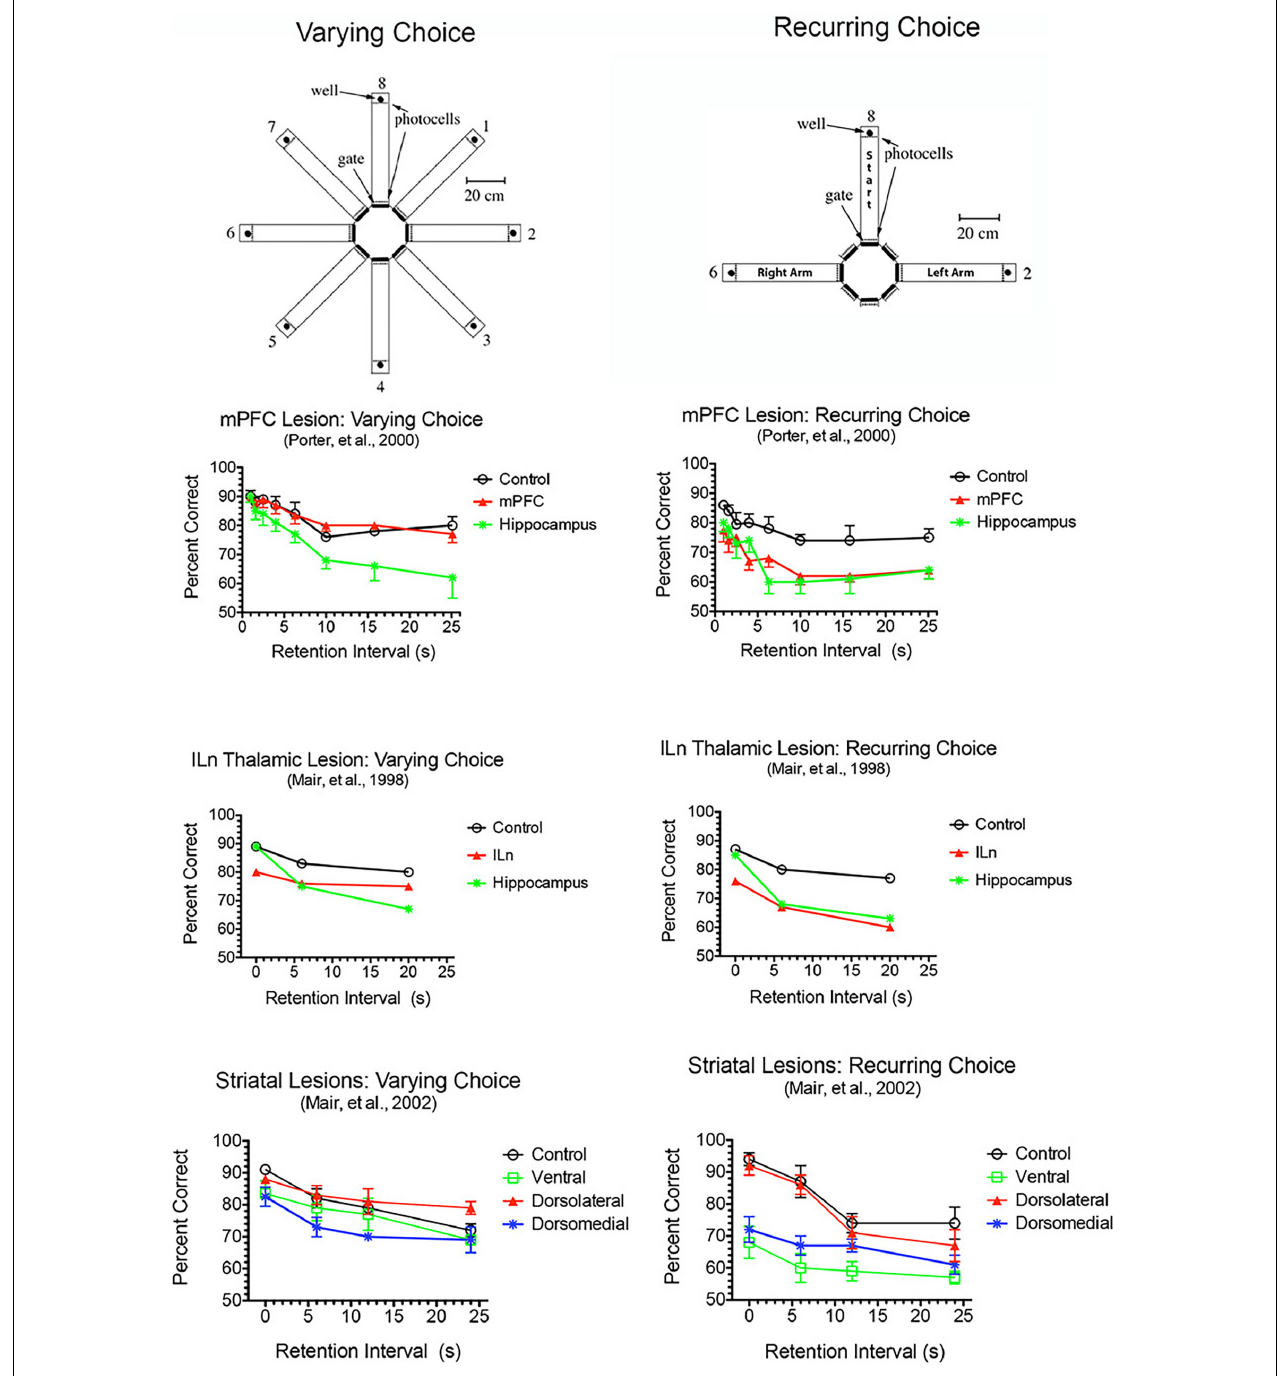
FIGURE 4 | Effects of mPFC, hippocampal, intralaminar thalamic (ILn), and striatal lesions on varying- and recurring-choice DNMTP trained in automated eight arm radial mazes. In varying choice DNMTP arms were selected at random from all available options for start, sample, delay, and choice responses in a lighted room with many visible external cues to favor an allocentric solution and to eliminate the possibility that a correct choice could be determined prospectively. In recurring choice, the same three arms (in a T-configuration) were used on every trial for start/delay and left and right sample/choice responses and mazes were covered and the room darkened to minimize external cues and favor egocentric choice and prospective decision making. mPFC lesions spared varying-choice and produced delay-independent deficits for recurring-choice DNMTP. Hippocampal lesions produced delay-dependent deficits for both versions, consistent with rapid decay of working memory. ILn lesions produced delay-independent deficits for both versions, consistent with the effects of dorsomedial striatal lesions. The ventral striatal lesion group were impaired for recurring-choice DNMTP and were impaired compared to the dorsolateral but not the control group for varying-choice DNMTP. Error bars represent standard error of the